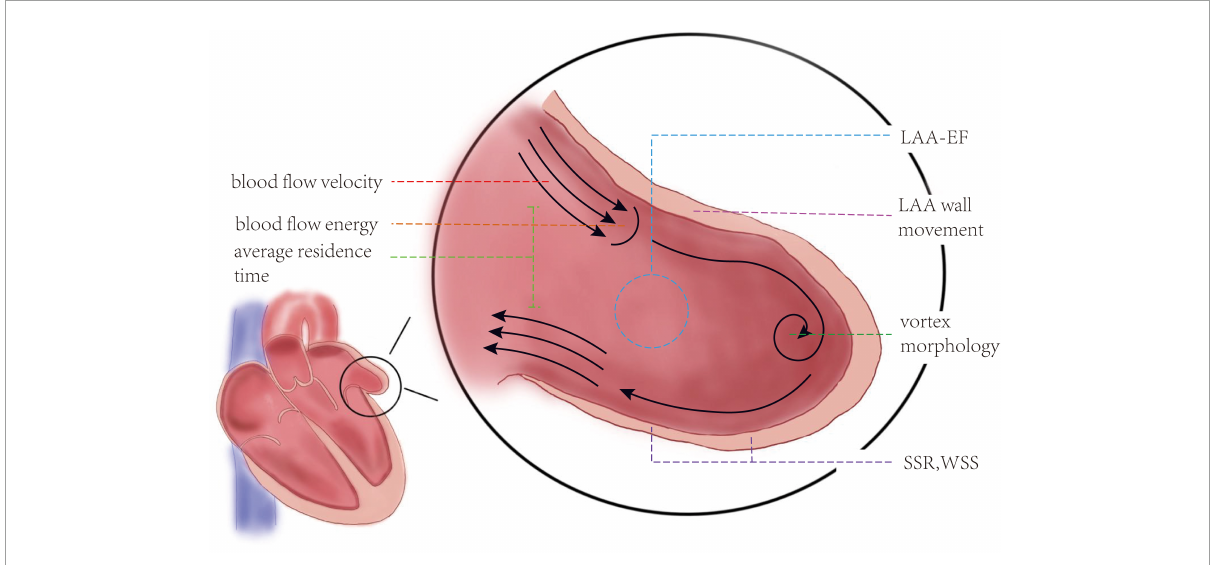
FIGURE3 Definitions of the hemodynamic indicators. Blood flow velocity: the speed blood goes into or out of left atrial appendage (LAA). To study the relationship between blood flow velocity and thrombosis, it is divided into LAA-AEV, LAA-AFV, LAA-PEV, and LAA-FPV. Blood flow energy: the kinetic energy of blood flow. Average residence time: the time that blood stays in the LAA. LAA-EF: left atrial appendage ejection fraction, usually calculated by area change rate, LAAEF = (maximum area of LAA–minimum area of LAA)/maximum area of LAA. Vortex morphology: the shape of vortex blood flow, such as the location of the vortex core. LAA motion velocity: the systolic velocity and diastolic velocity of each wall of the LAA. SSR, systolic strain rate; the overall maximum negative strain rate in systole was taken as the SSR. WSS, wall shear stress; shear stress is defined as the component of stress coplanar with a material cross-section. WSS shows the friction between blood and LAA